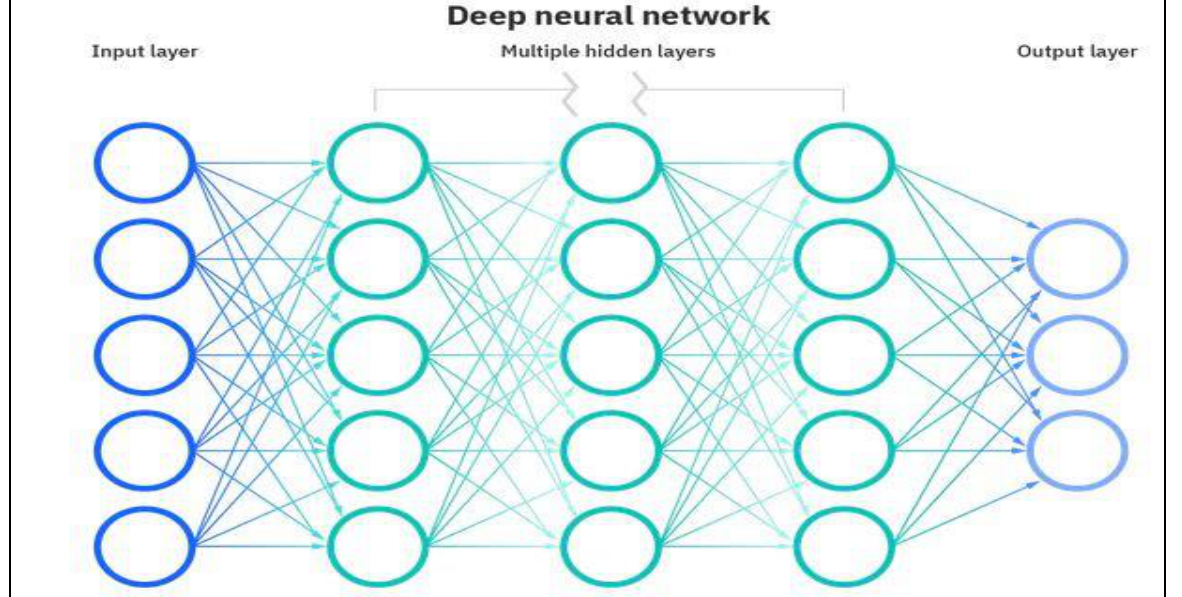
Figure 3. Deep Learning Algorithm, from